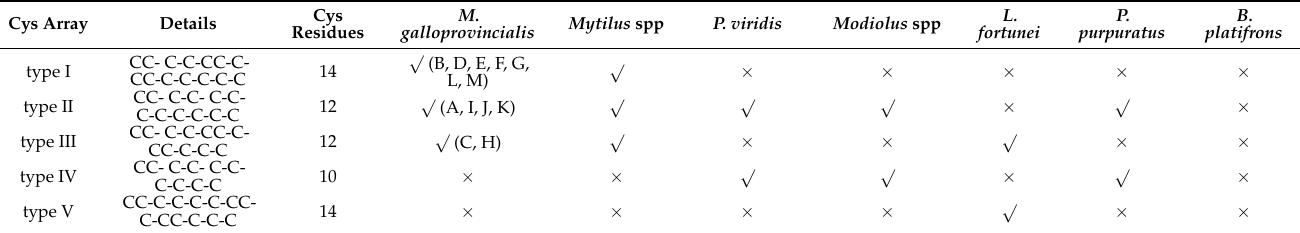
Table 1. Taxonomic distribution of the mytimycin cysteine arrays observed in Mytilida. For M. galloprovincialis , the type Cys Array